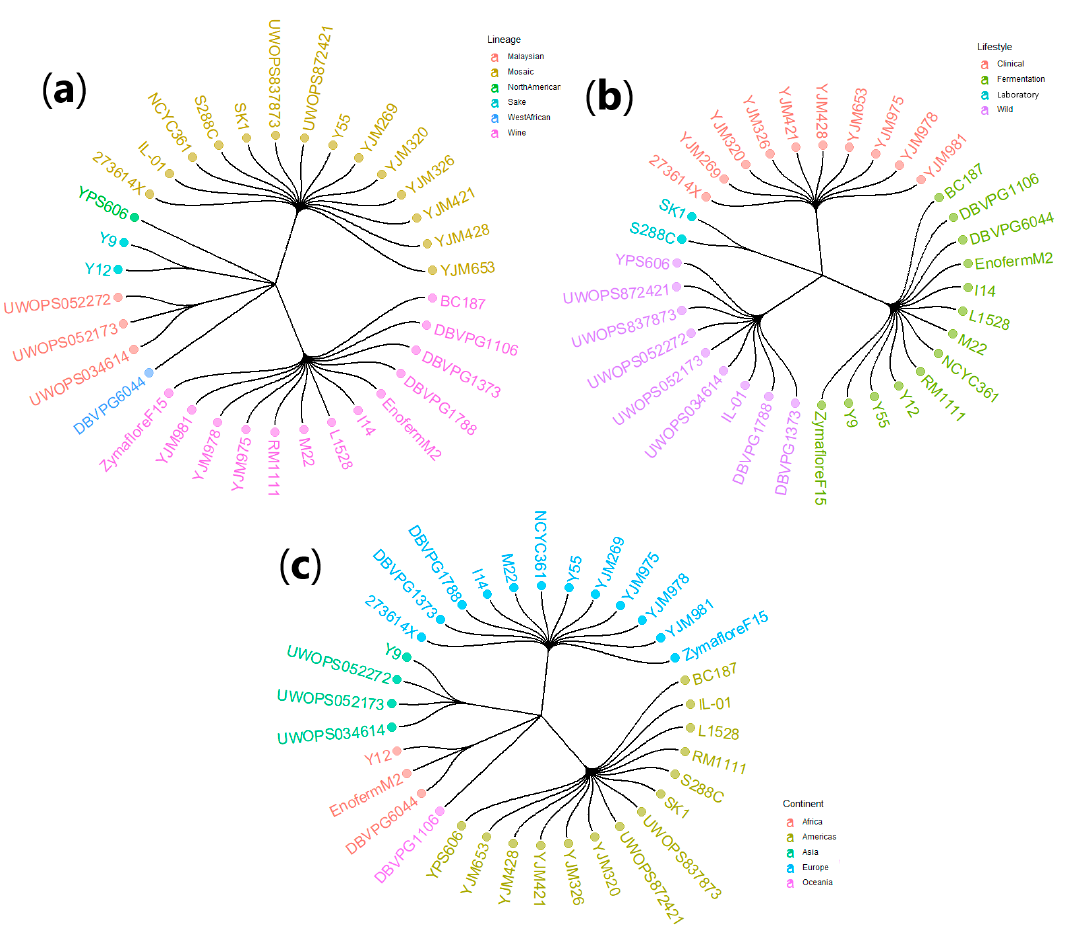
Figure 1. Dendrograms depicting the 34 S. cerevisiae strains analyzed in this investigation and grouped based on: ( a ) lineage (Malaysian, Mosaic, North American, Sake, West African, Wine); ( b ) lifestyle (Clinical, Fermentation, Laboratory, Wild); and ( c ) continent / geographical origin (Africa, Americas, Asia, Europe, Oceania).